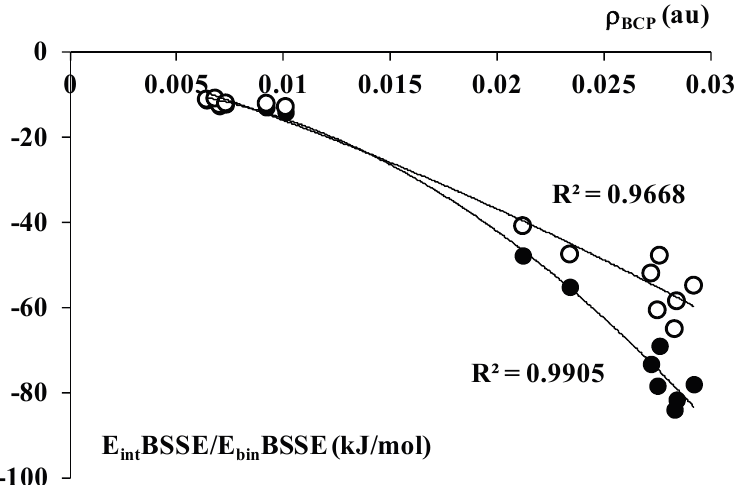
Figure 4. The second order polynomial relationships between the electron density at BCP, ρ BCP (in au), and the E int BSSE as well as E bin BSSE, black and white points, respectively (energies in kJ/mol). The E int BSSE and E bin BSSE are corrected for BSSE and they correspond to E int and E bin defined by Equations (1) and (2),